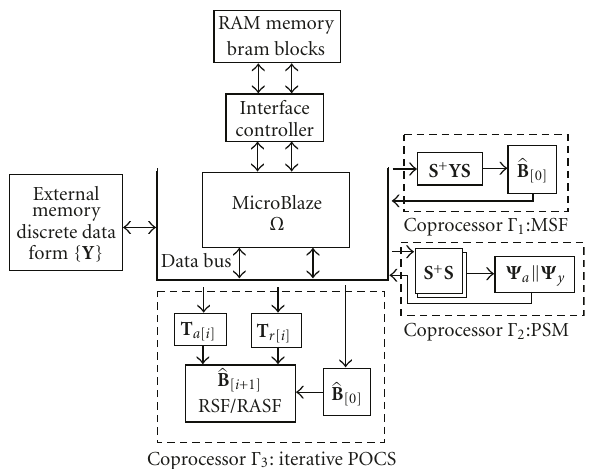
Figure 4: Illustration of the partitioning phase of the HW/SW